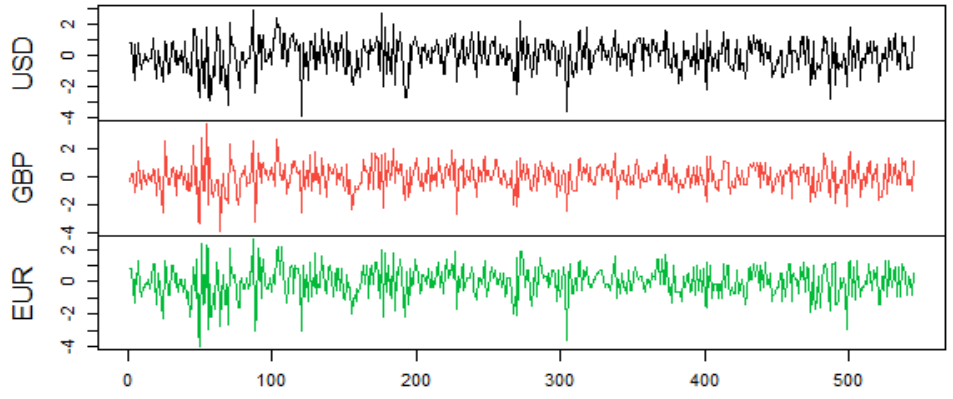
Figure A2. Daily foreign exchange rate returns. Note: Figure A2 shows the daily foreign exchange rate return during the COVID-19 pandemic for three currency pairs. USD is the US dollar exchange rate against the South African rand, GBP is the British pound against rand, and EUR is Euro against the rand.